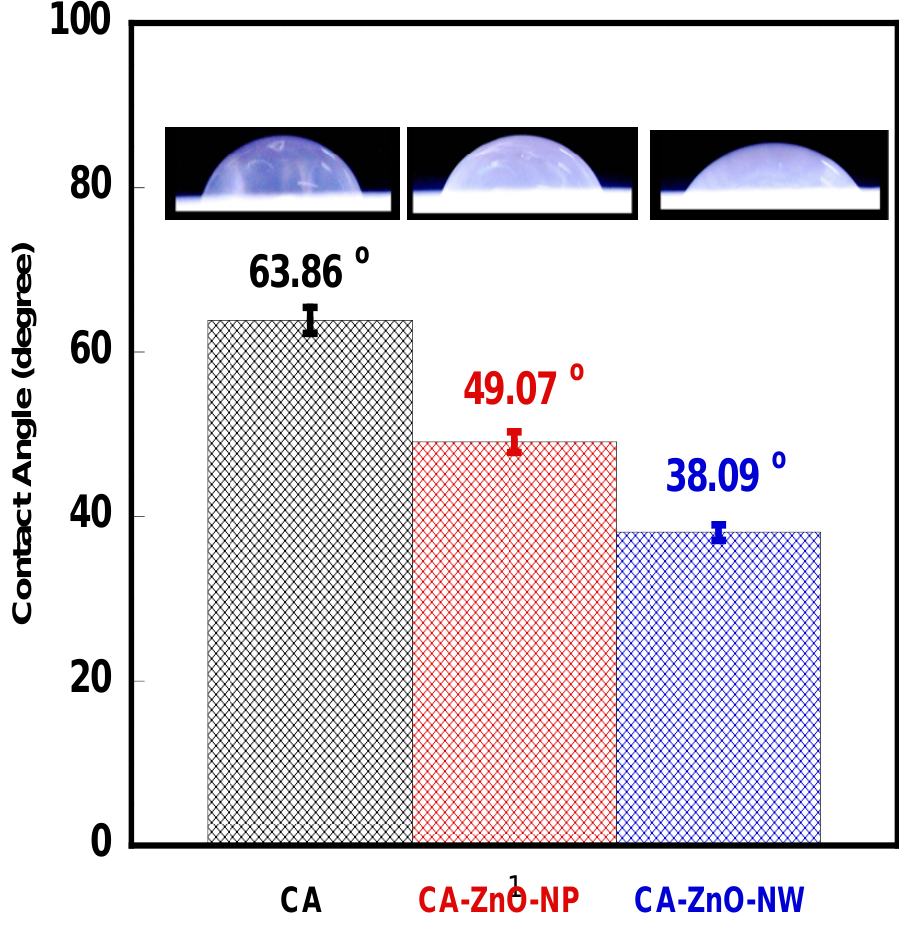
Figure 6. Contact angle measurements of the pristine CA membrane, the CA-ZnO-NP membrane, and the CA-ZnO-NW membrane. The insets show a photograph of a water droplet on each membrane.